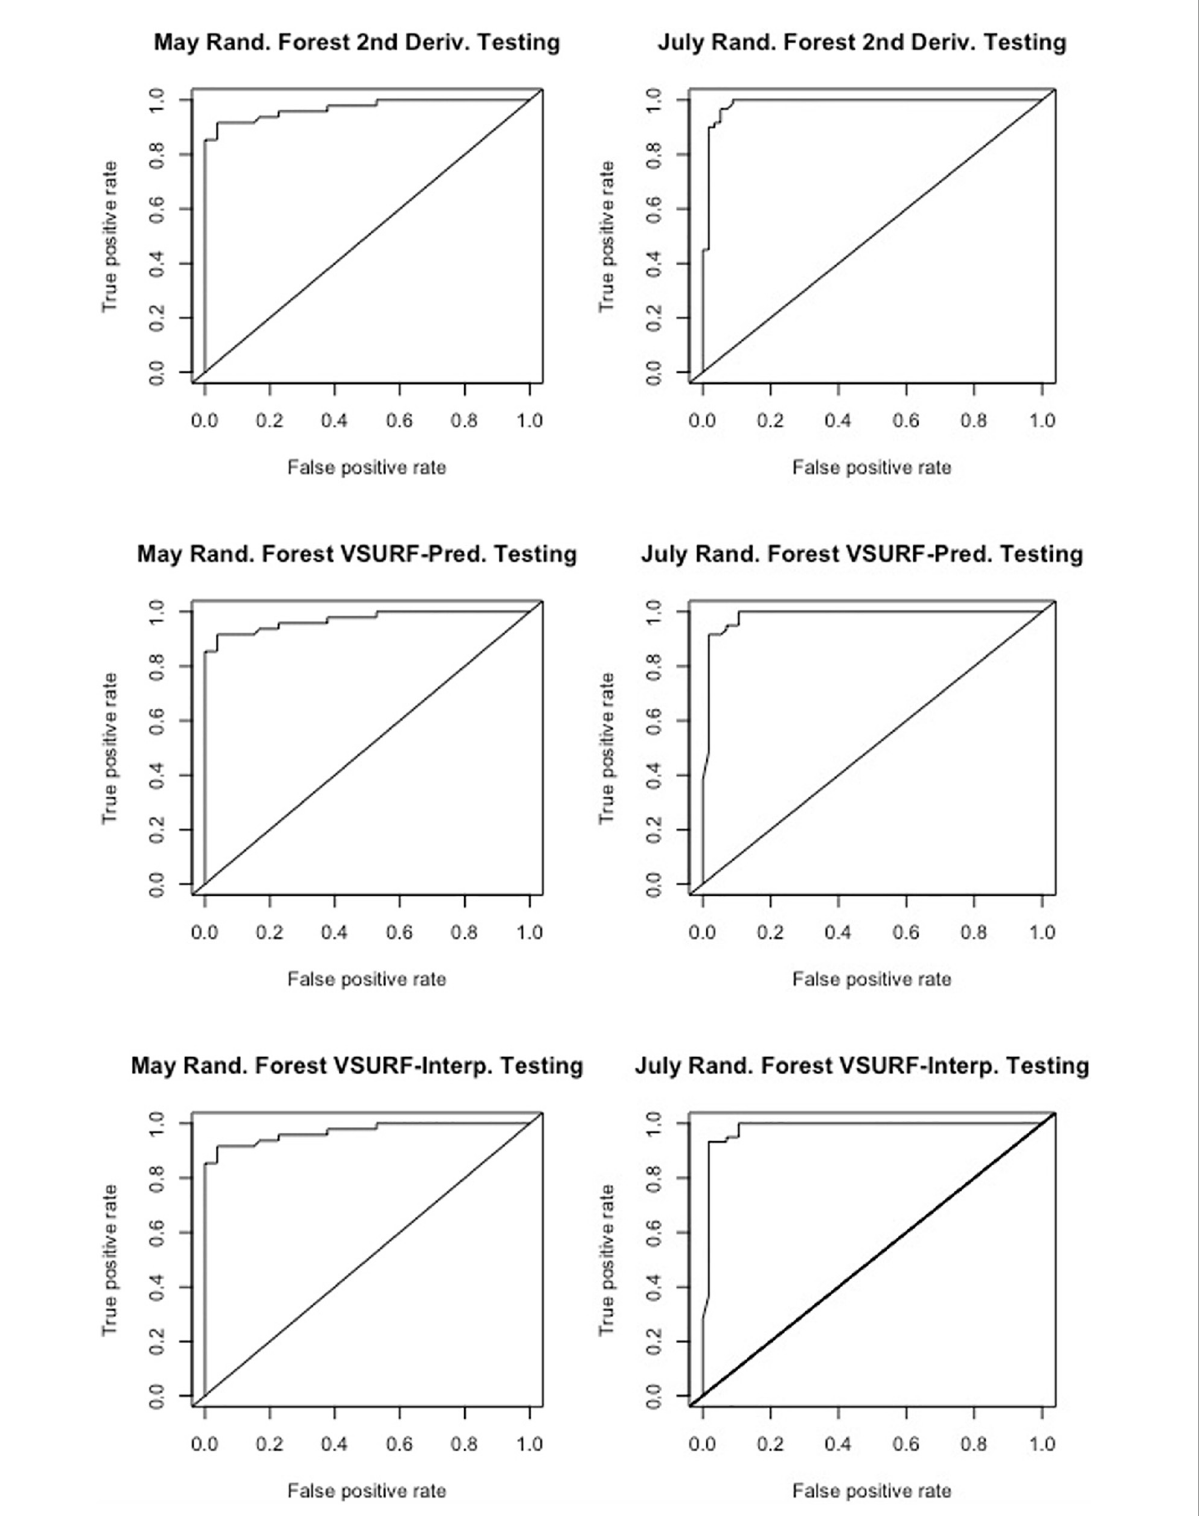
FIGURE4 Receiver operating characteristic (ROC) curves derived from the testing of the random forest models, showing the classification accuracy of spectra from pre-symptomatic samples (excluding the Kiwanis site) and distal-naïve samples for the both the May (left) and July (right) datasets. The diagonal line represents perfect chance